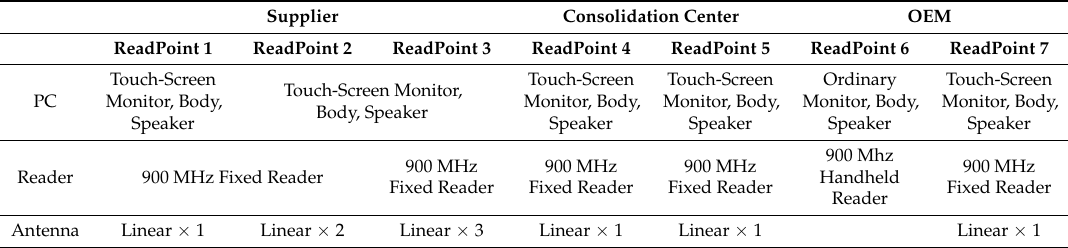
Table 1. Summary of Hardware Configuration.